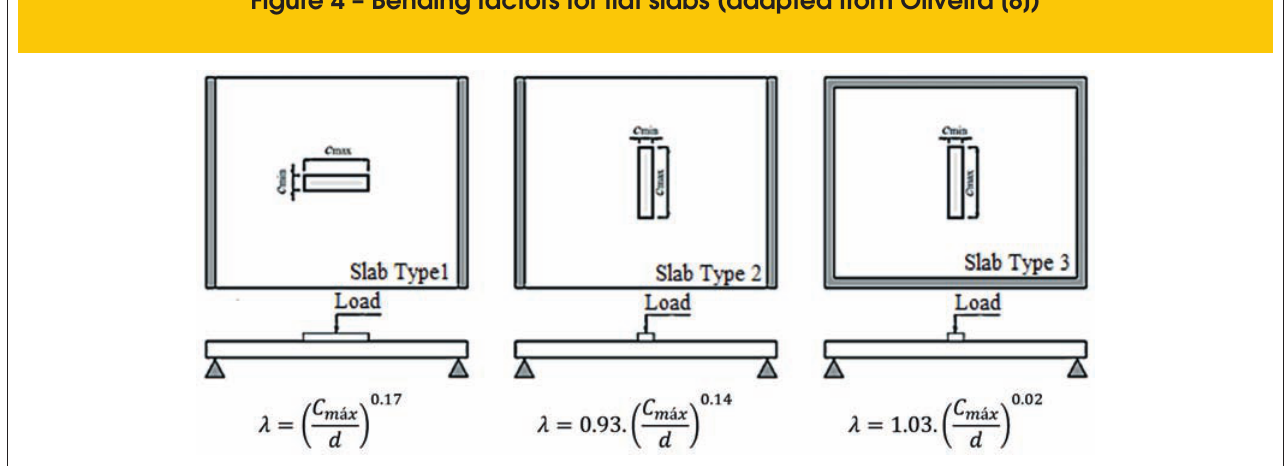
Figure 4 – Bending factors for flat slabs (adapted from Oliveira [8])